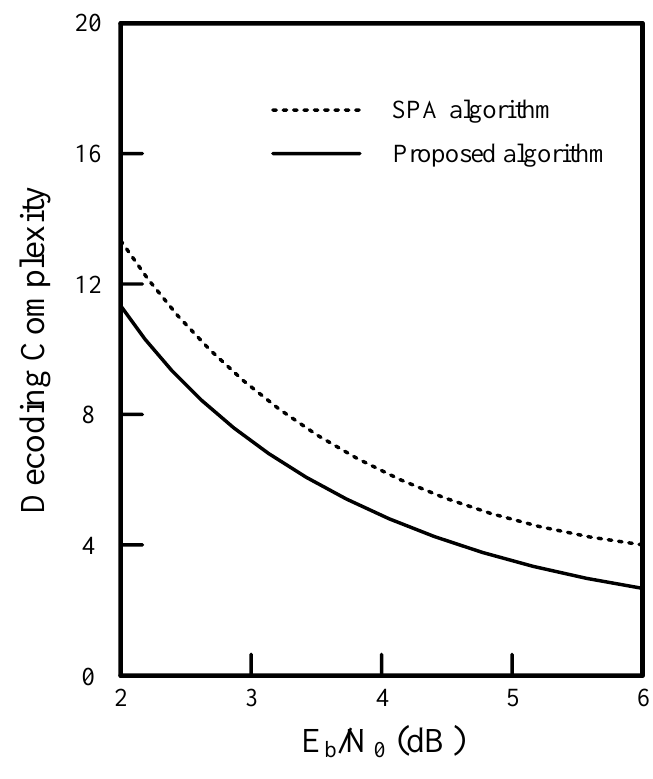
Figure 5. Complexity of Reed-Muller (64,